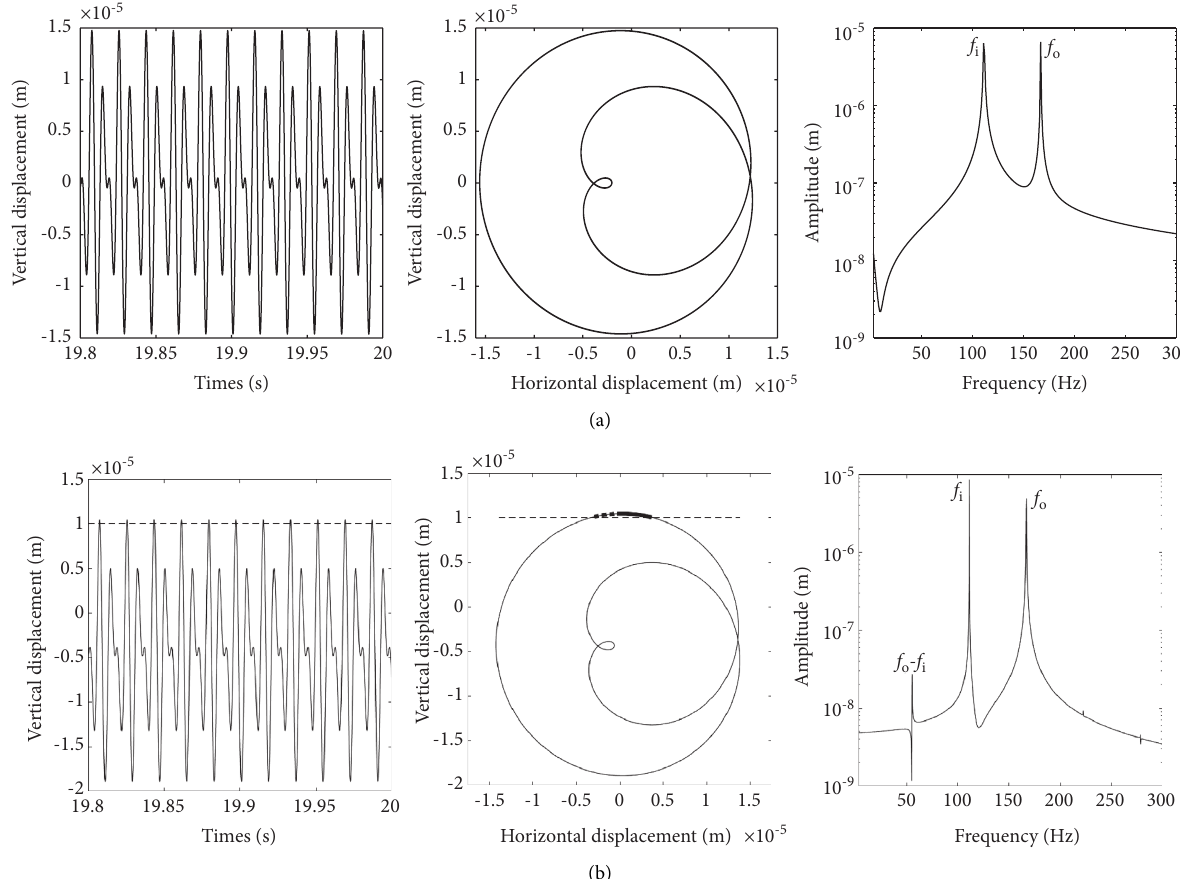
Figure 13: Dynamic responses of the MSDS with K response with rub-impact.